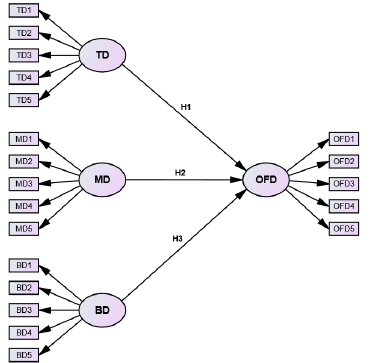
Fig. 1. Research conceptual